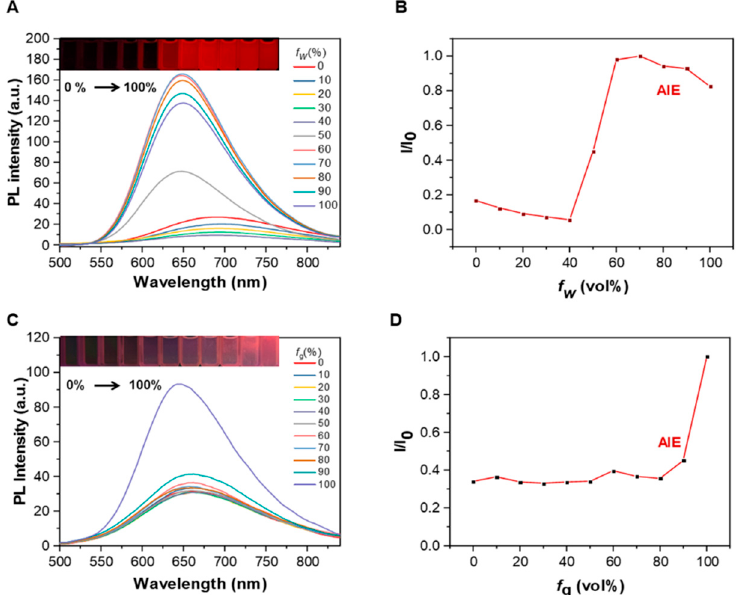
Figure 2. ( A ) PL intensity at different f w (10 µ M) and the photograph of mixtures with increasing volume fractions of water (from left to right) under 365 nm UV light. ( B ) The relative PL intensity against water content. (I 0 : PL Intensity of 70% H 2 O). ( C ) PL intensity of BY1 in ethanol/glycerol mixture with varied f g (10 µ M) under 365 nm UV light. ( D ) The relative PL intensity against glycerol content. (I 0 : PL Intensity of 100% glycerol). Table 1. Quantum Yield (QY) of the BY1 in 0% H 2 O, 70% H 2 O and powder. Compound